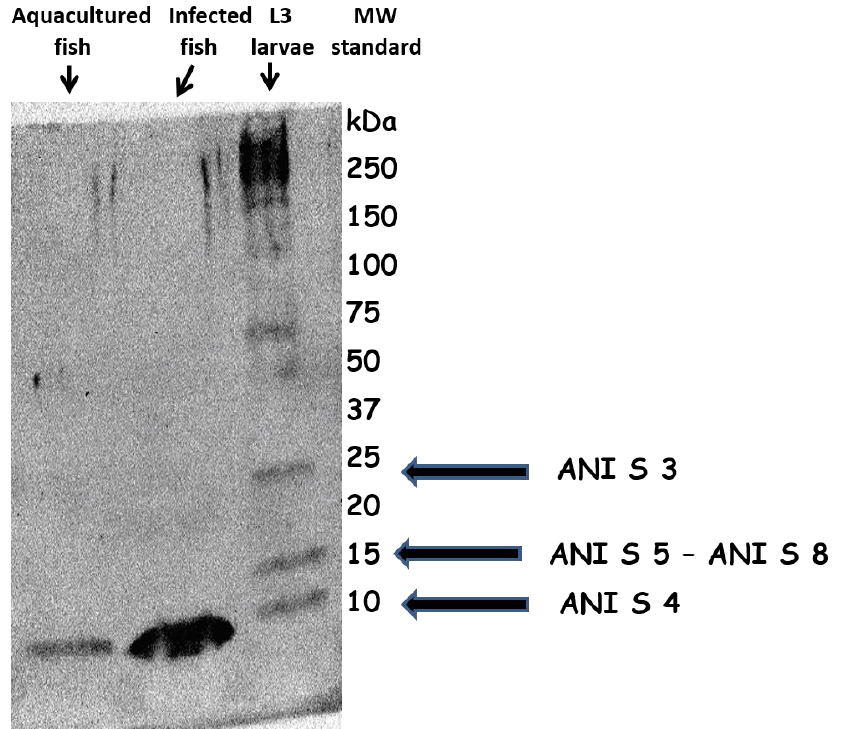
Figure 1. WB analysis of protein extracts from aquacultured fish, A. simplex L3 larvae-infected fish and A. simplex L3 larvae. MW identification shows, in the edible part of both fishes, the presence of an immunodetected protein signal similar to the Ani s4 allergen of A. simplex L3 larvae. Biology 2021 , 10 , 106